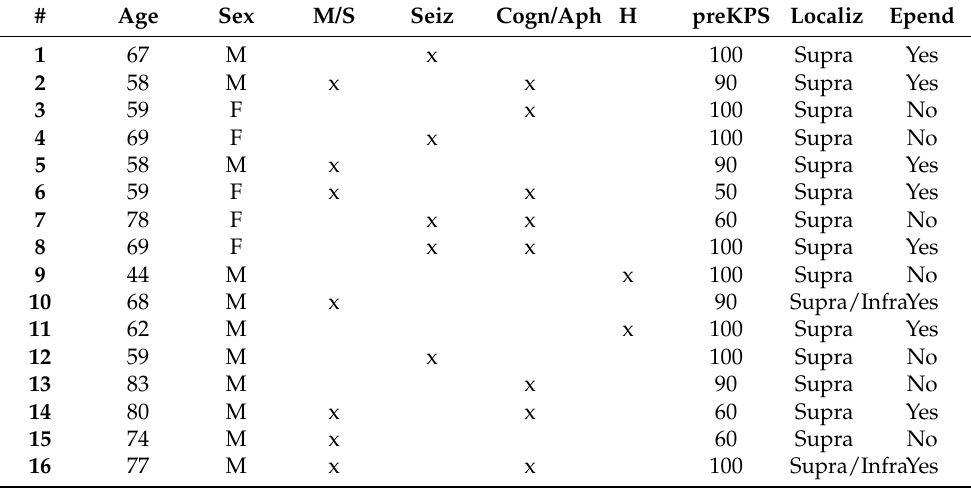
Table 1. Patients preoperative clinical data . M/S: motor and/or sensitive deficits; Seiz: seizures; Cogn/Aph: cognitive disorders and/or aphasia; H: headache; Localiz: localization; Epend: ependy- mal